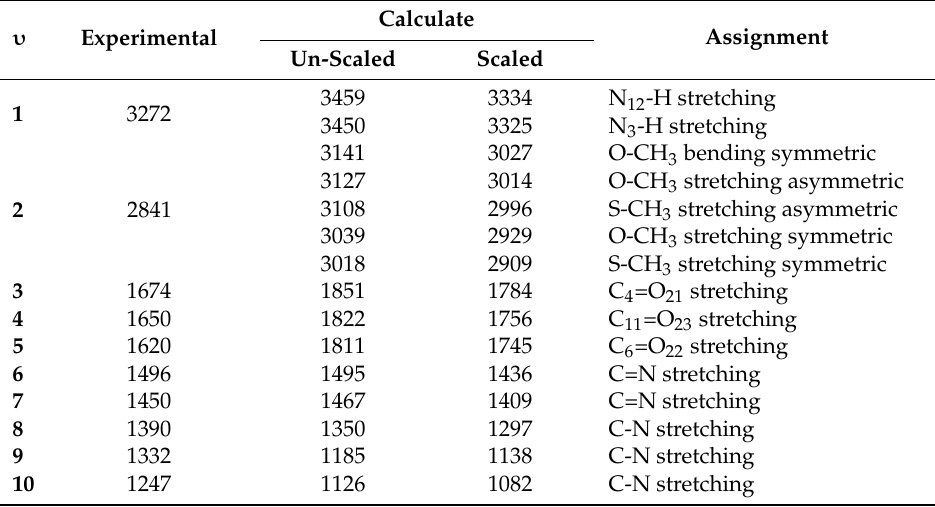
Table 4. Fourier Transform infrared spectroscopy (FT-IR) Experimental and computed vibrational bands for compound 4c and their assignments at B3LYP/6-31G(d,p)